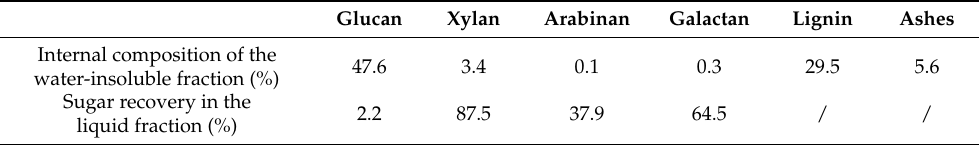
Table 2. Composition of pre-treated wheat straw. (a): Internal composition of water-insoluble fraction; (b): sugar solubilization recovery in the liquid fraction, with respect to each sugar in the initial raw material. Glucan Xylan Arabinan Galactan Lignin Ashes Internal composition of the 47.6 3.4 0.1 0.3 29.5 5.6 water-insoluble fraction (%) Sugar recovery in the 2.2 87.5 37.9 64.5 / liquid fraction (%)